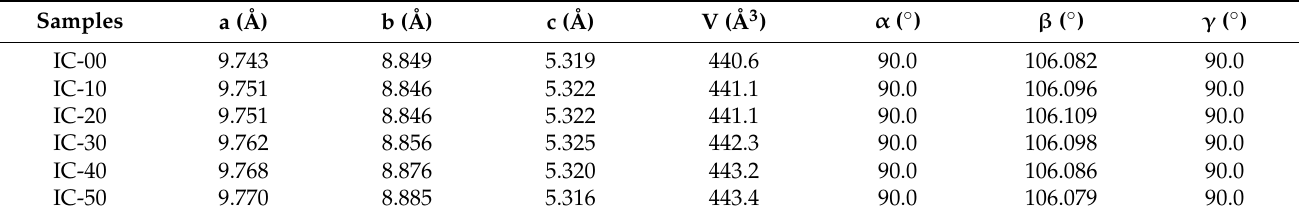
Table 5. Cell parameters and volumes of Fe-bearing